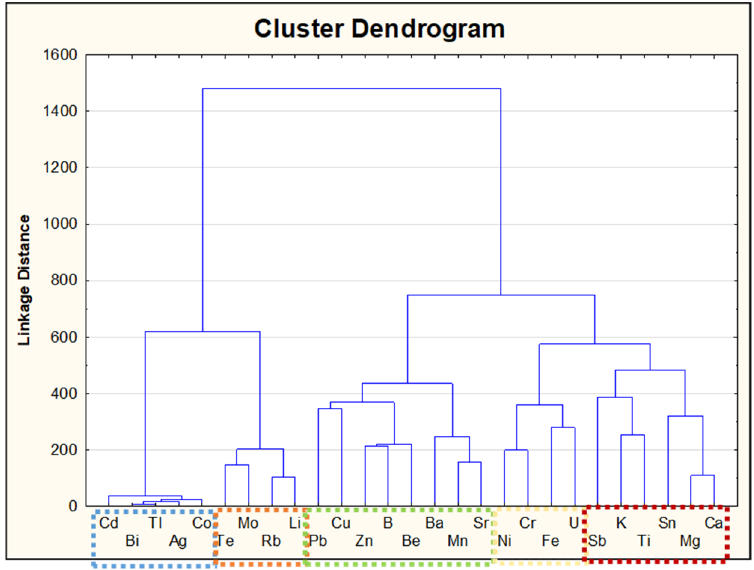
Figure 4. Hierarchical cluster dendrogram for 18 variables.